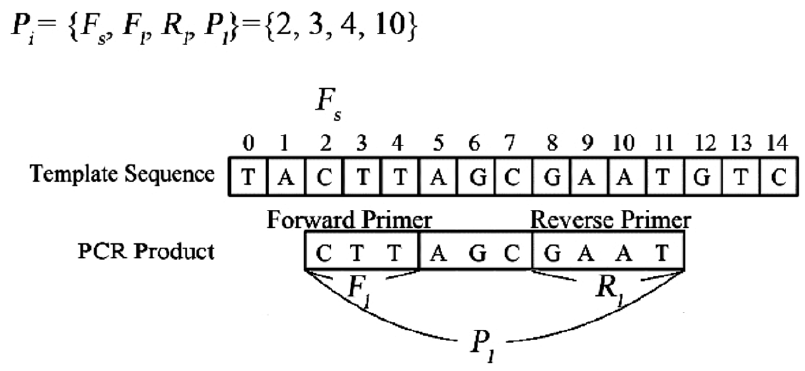
Figure 3. Illustration of the structure of a particle in PSO.